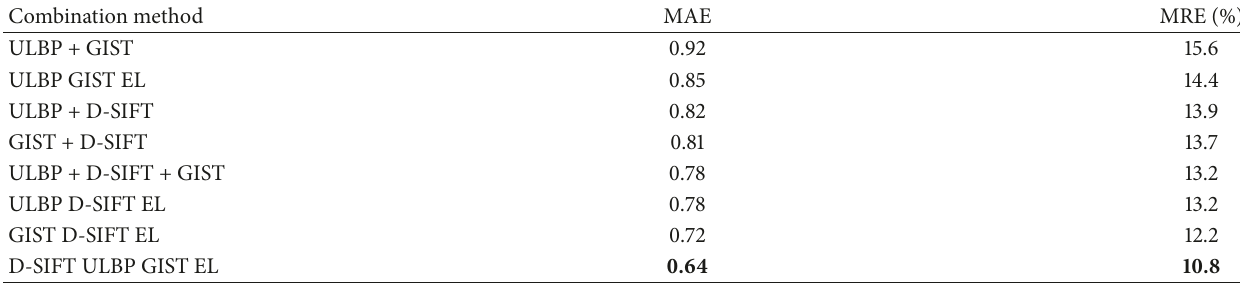
Table 2: Comparison between multifeature combinations.